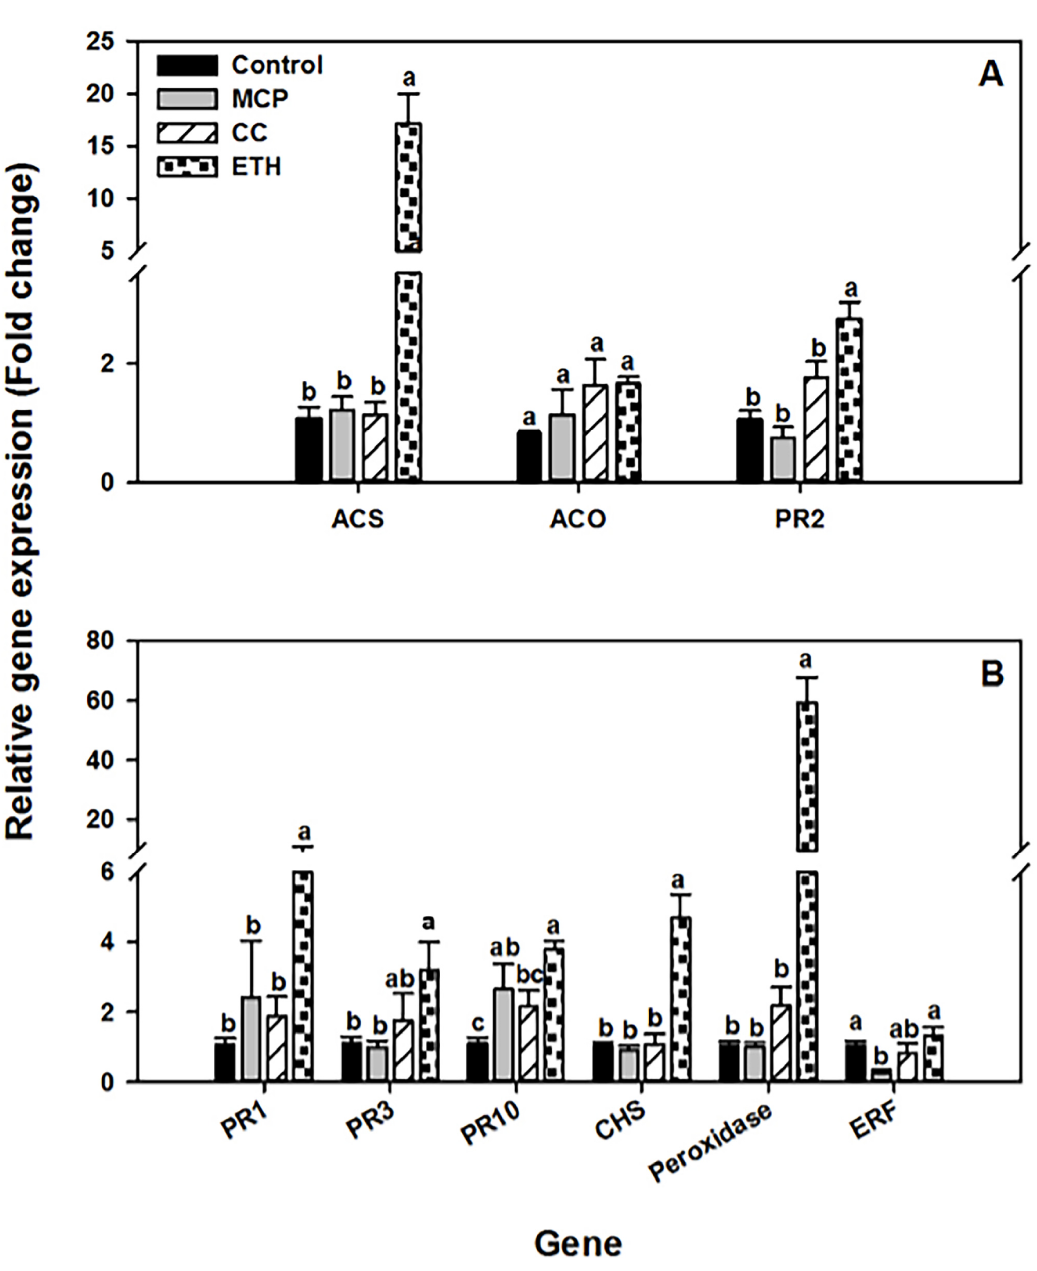
Fig 4. Effect of chemical treatment on defense gene expression in MN1606. Expression analysis of soybean genes twenty-four hours after exposer to water (control), 1-methylcyclopropene (MCP), cobalt chloride 1mM (CC), or ethephon 4mM (ETH) in the resistant cultivar MN1606. (A) Genes involved in ethylene biosynthesis and signaling, 1-aminocyclopropane-1-carboxylic acid synthase ( ACS ), 1-aminocyclopropane-1-carboxylic acid oxidase ( ACO ), and β -1,3-endoglucanase ( PR2 ), (B) defense-related genes, pathogenesis-related protein 1 ( PR1 ), Chitinase class I ( PR3 ), Intercellular pathogenesis-related protein 10 ( PR10 ), Chalcone synthase ( CHS ), basic peroxidase ( Peroxidase ), and ethylene response factor 1 ( ERF1 ). Soybean seedlings were drenched with water (control), ethephon 4 mM, cobalt chloride 1 mM, or foliar sprayed with 1-MCP. Roots were sampled 24 hours after chemical treatment. The soybean actin gene was used as an internal control. The level of expression is shown relative to that of control plants. Each column represents the mean fold change of eight biological samples (four samples × two runs), and each sample consisted of a pool of two plants. Error bar indicates standard error of the mean (n = 8). Columns with different letters are significantly different ( P <